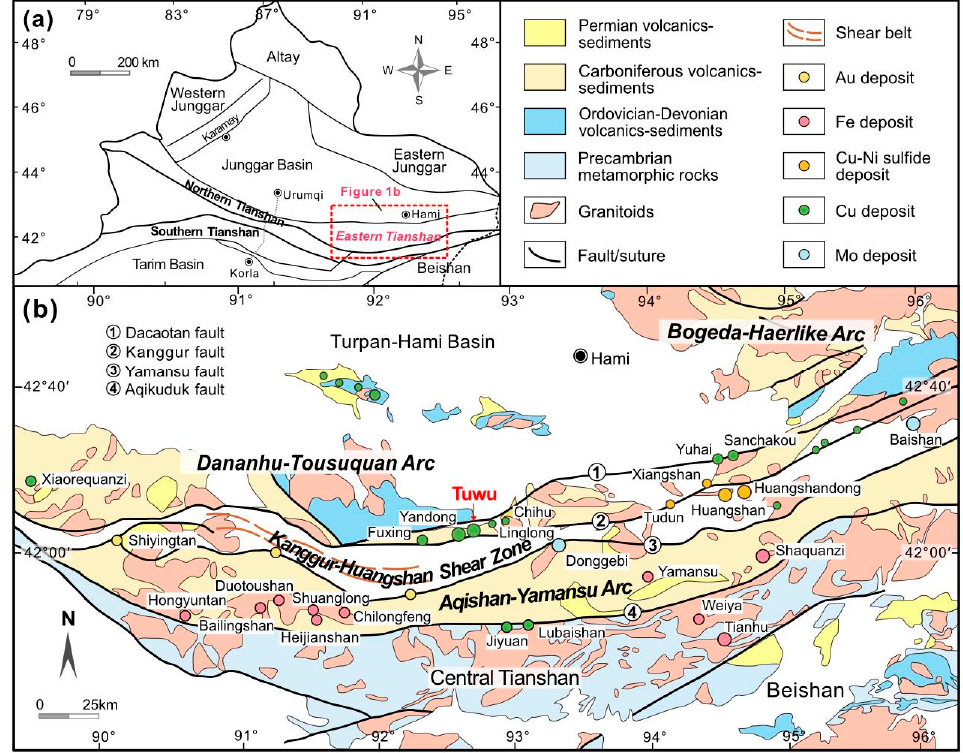
Figure 1. ( a ) Geological map of NW China showing the main tectonic units, and ( b ) geological map of Eastern Tianshan Orogen showing major tectonic units, faults and ore deposits (modified from [28]).